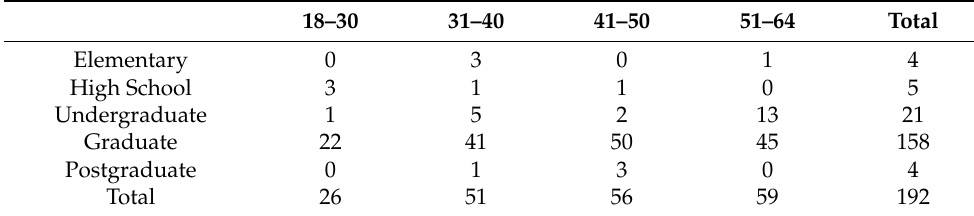
Table 3. Level of education and age of